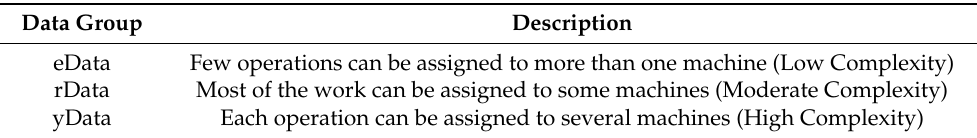
Table 3. Groups of benchmark problems in the Hurink library.